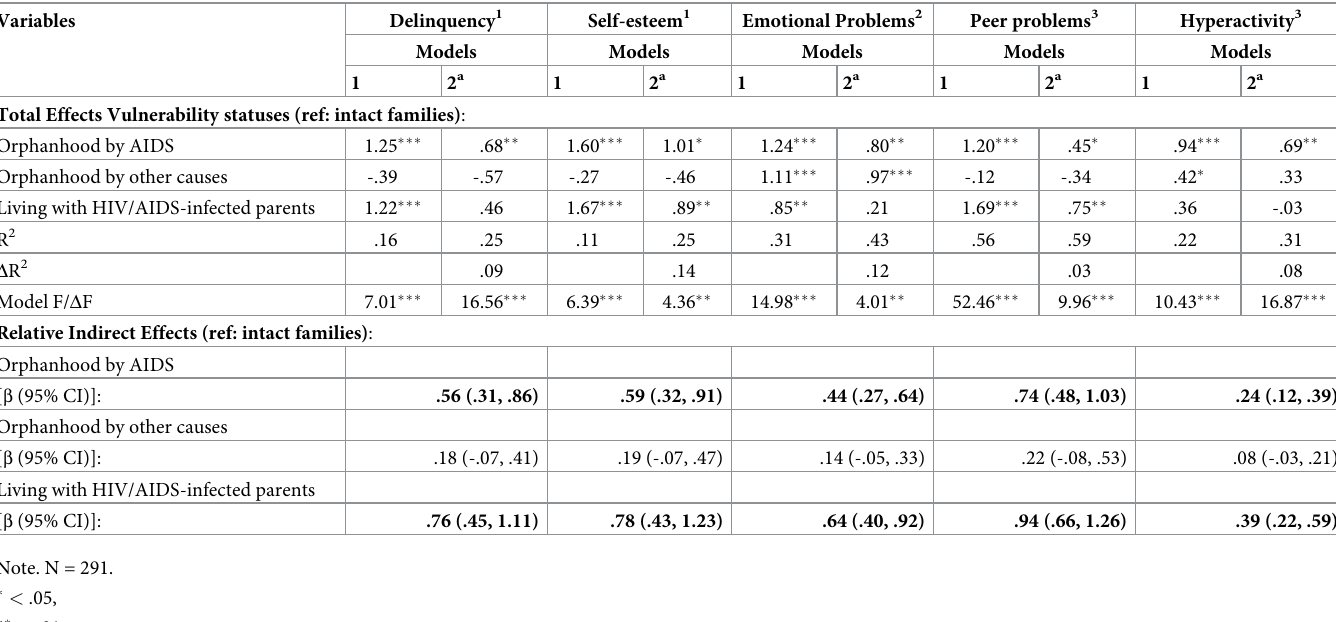
Table 2. Results for mediation